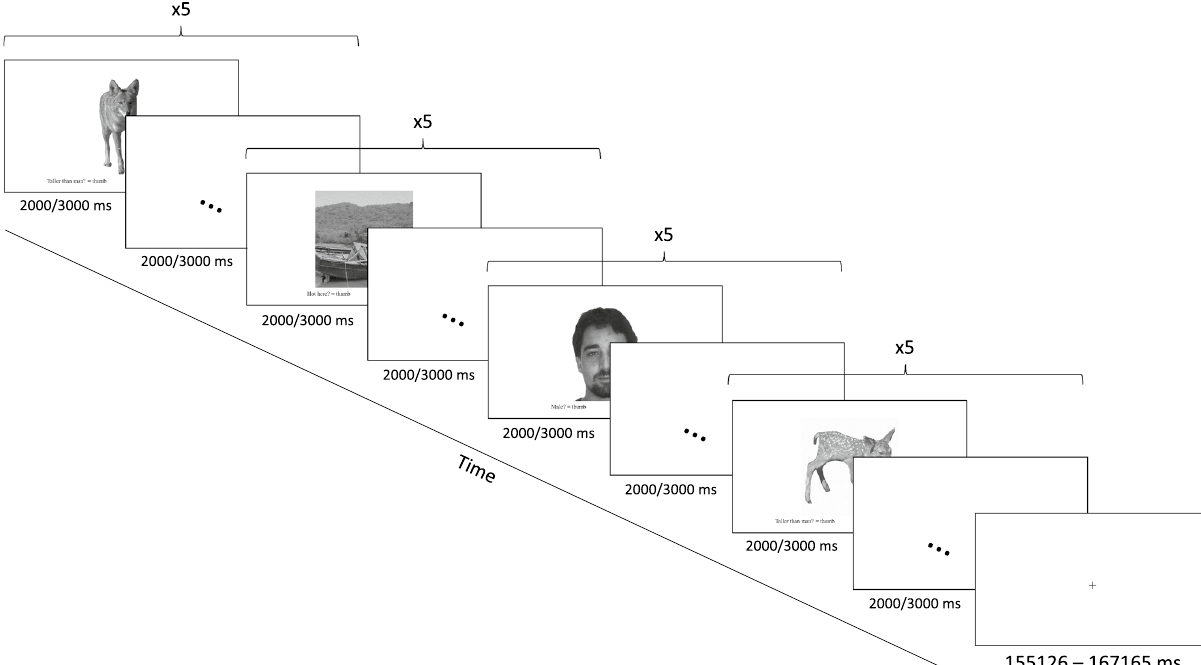
Figure 2. Schematic diagram of the episodic encoding task. Participants were presented with 20 images per block (with five images from each stimulus category presented consecutively) and were instructed to respond to the various stimuli on screen based on set criteria. Each stimulus was presented for 2/3 s, followed by an inter- stimulus duration of 2/3 s. Stimuli were sourced from the Psychological Collection of Images at Stirling database (available at pics.stir.ac.uk), the Centre for Vital Longevity Face Database (available at agingmind.utdallas.edu/ facedb), as well as other publicly available free-to-use image